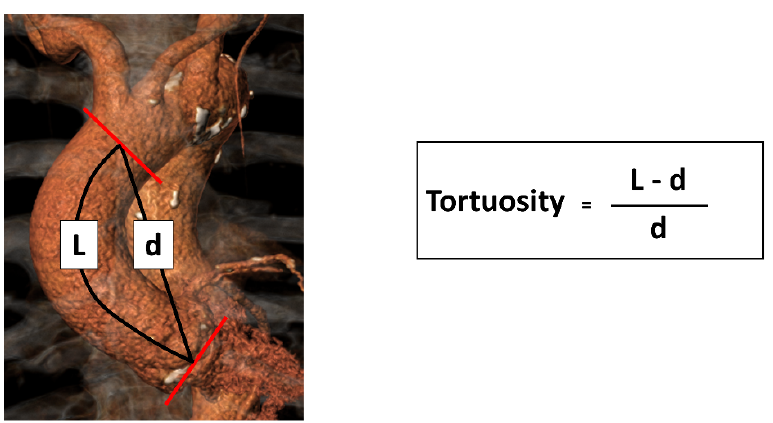
Figure 2. Pre-TAVI CTA in Volume Rendering Technique (VRT) for determination of Tortuosity. Tortuosity of the ascending aorta was calculated as ratio of its curved length (= L, curved black line) to the linear distance (= d, straight black line) between its two endpoints (annular plane and the proximal origin of the brachiocephalic artery, each marked with the red lines).